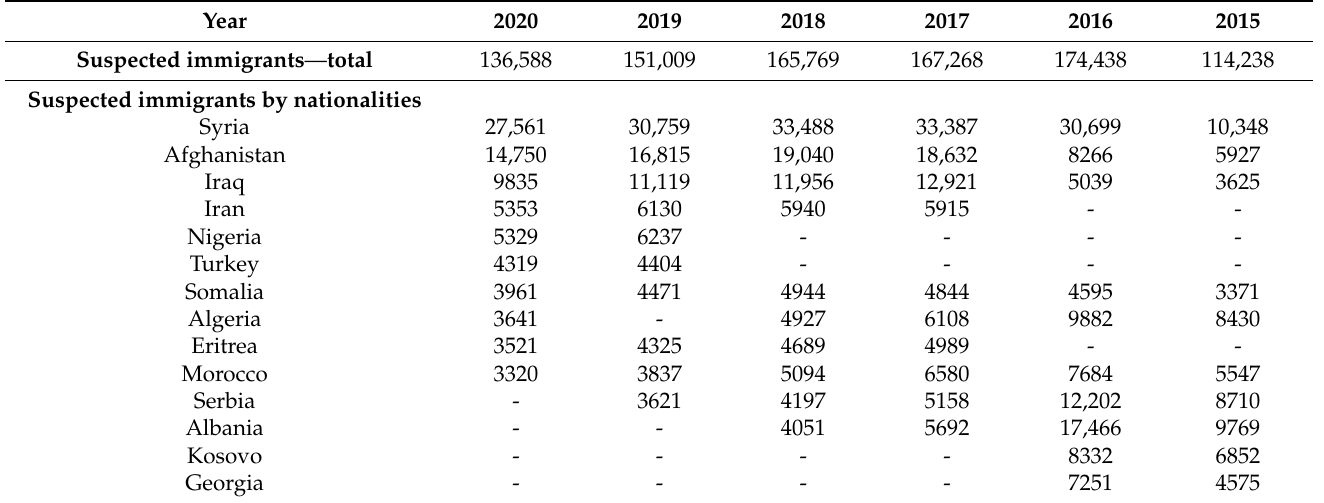
Table 4. Suspected immigrants (2015–2020). Source from BKA, Police Crime Statistics (Police Crime Statistics n.d.), table made by